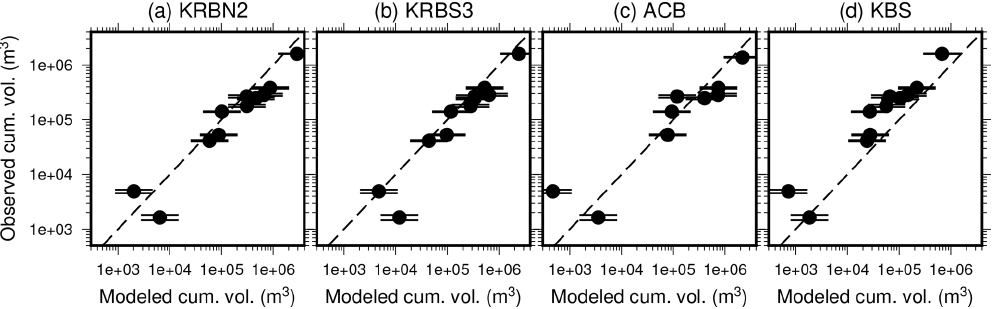
Figure 5. Modeled vs. observed cumulative volume for different lidar scanning intervals and stations in the 2016 calibrating period. Lidar measurement uncertainties are indicated with error bars (vertical distance between caps; too small to see for high volumes).